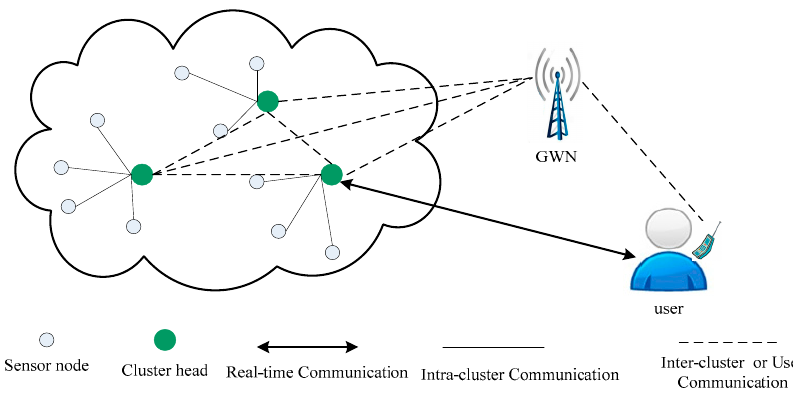
Figure 1. Real-time data access in WSNs.